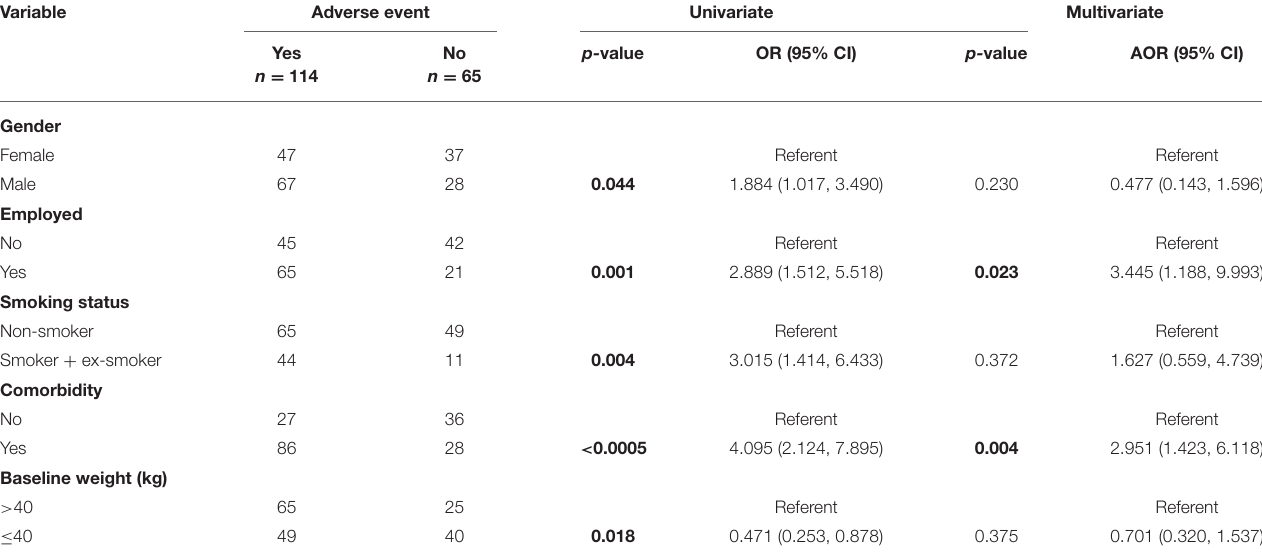
TABLE 5 | Factors associated with the occurrence of adverse